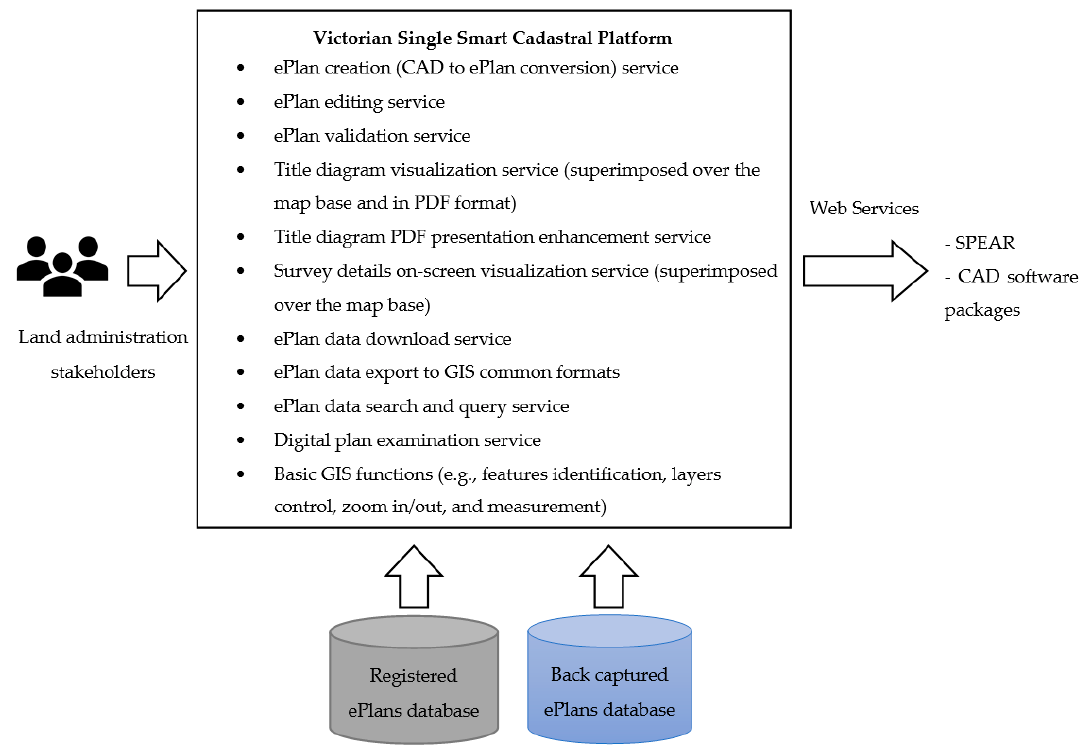
Figure 3. Victorian single smart cadastral platform components.